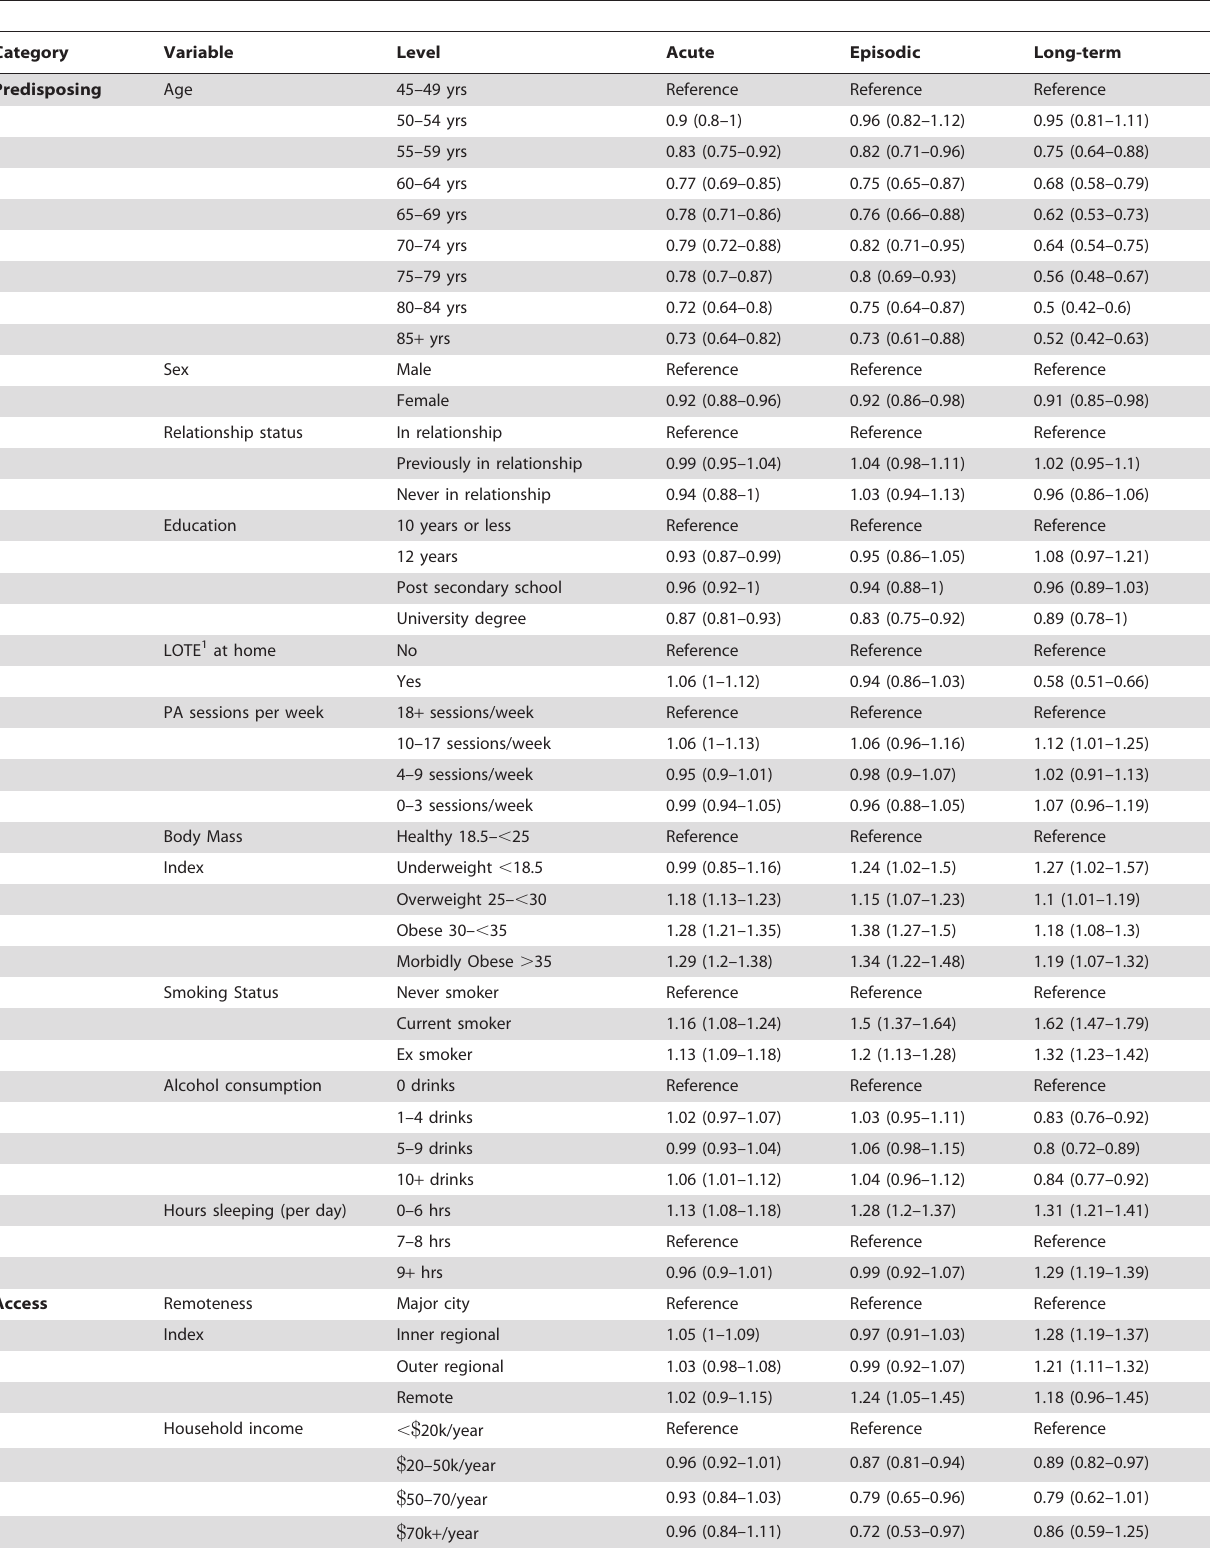
Table 5. Rate-ratio (RR) of the association of variables (by Andersen-Newman model categories of Predisposing, Access, and Need) belonging to a category of opioid use (Acute, Episodic, Long-term – see Methods and Materials for details) with non-users as the reference group, each variable fully adjusted by all variables in this